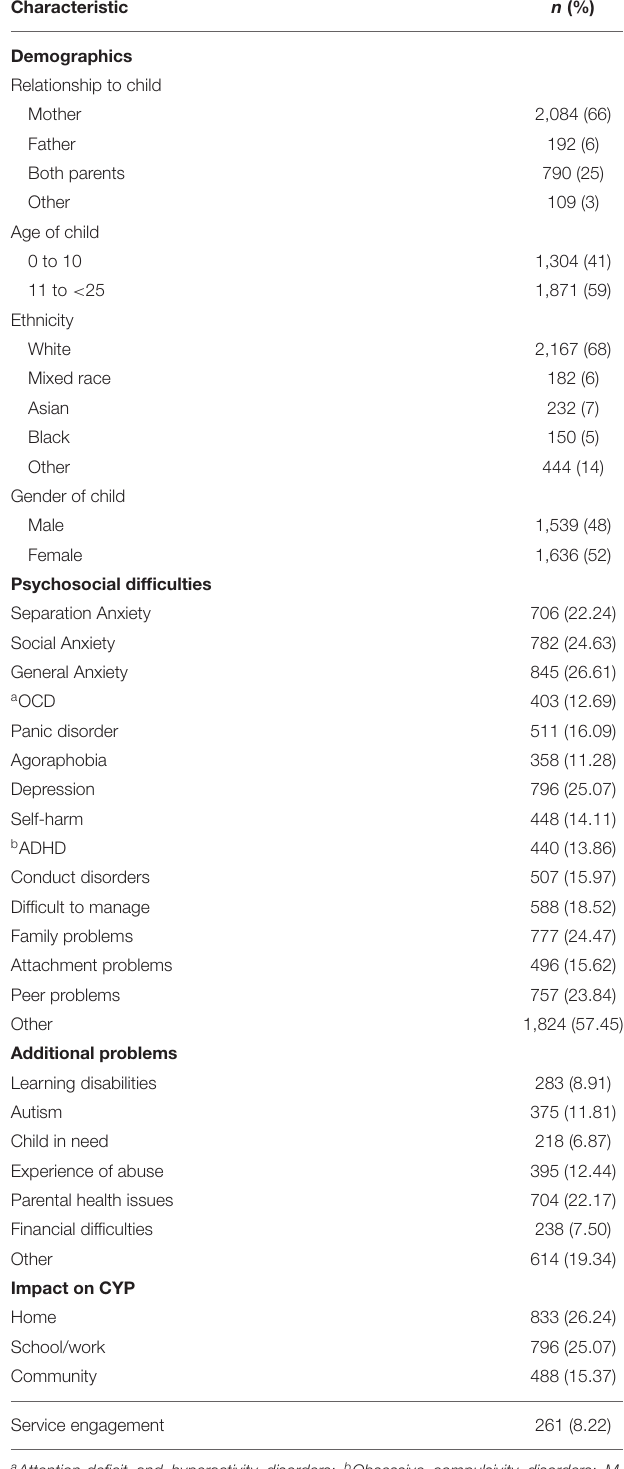
TABLE 1 | Characteristics of the